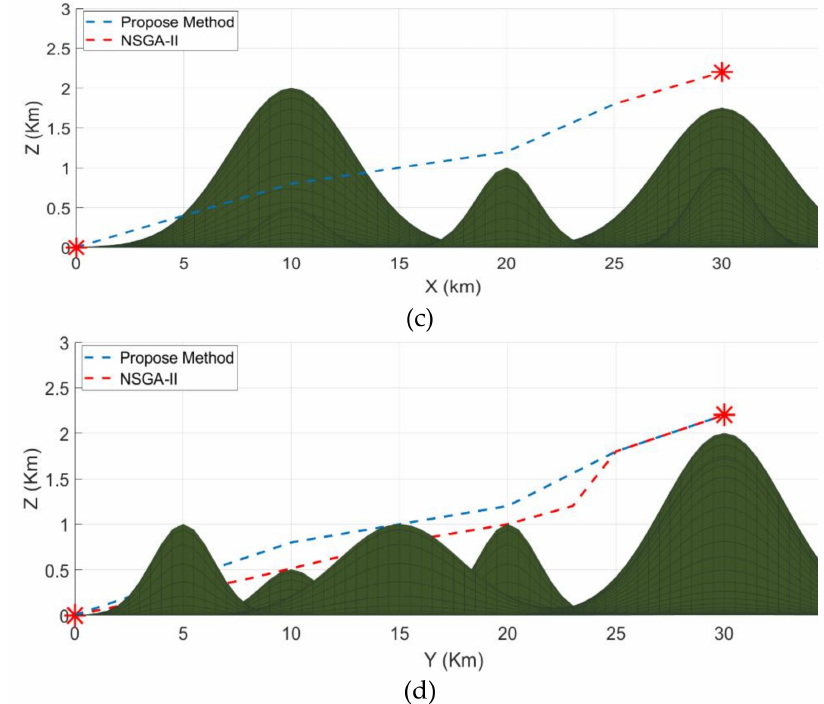
Figure 7. Comparison between NSGA-II and the proposed method; ( a ) shows the 3D version while ( b – d ) represent the XY , XZ , and YZ axis versions, respectively. The legend is the same for all